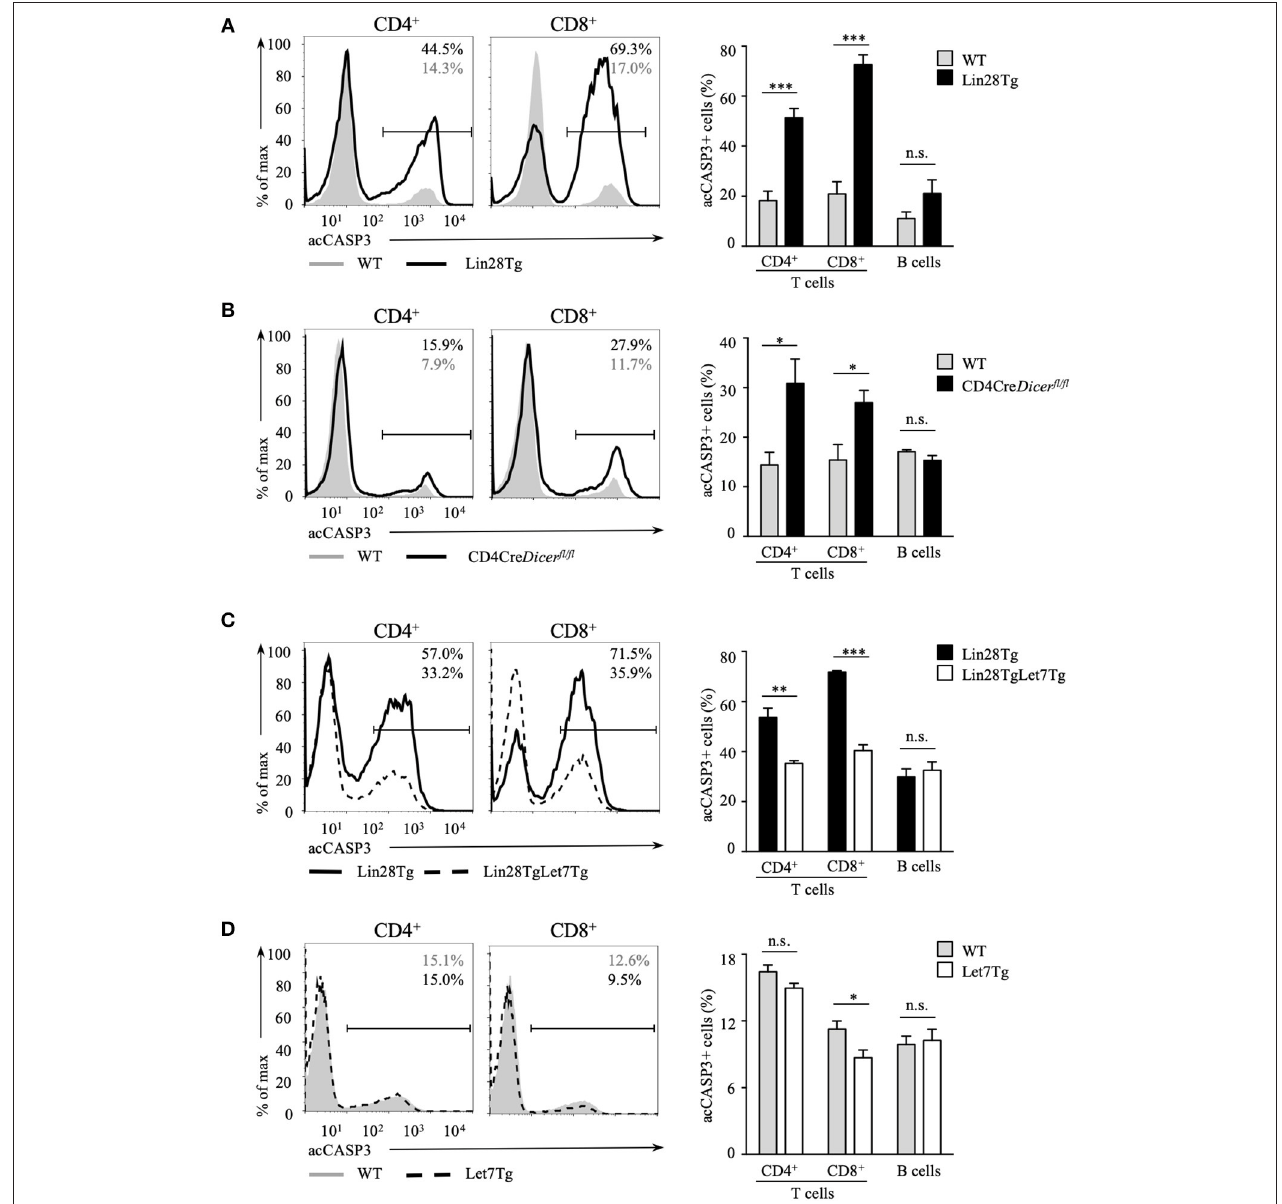
FIGURE 2 | Let-7 is essential in protecting T cells from apoptosis. Intracellular staining for active Caspase-3 (left) and frequency of acCasp3 + population (right) in CD4 and CD8 lymph node T cells from (A) wild type ( n = 4) and Lin28Tg ( n = 4) mice, (B) wild type ( n = 6) and CD4Cre + Dicer fl / fl ( n = 6) mice, (C) Lin28Tg ( n = 3) and Lin28TgLet7Tg ( n = 3) mice, and (D) wild type ( n = 4) and Let7Tg ( n = 4) mice, cultured for 18h in media. Data are representative of at least three independent staining experiments and are displayed as mean ± SEM of each population from all mice; n.s., not significant ( p > 0.05), * p < 0.05, ** p < 0.01, *** p <